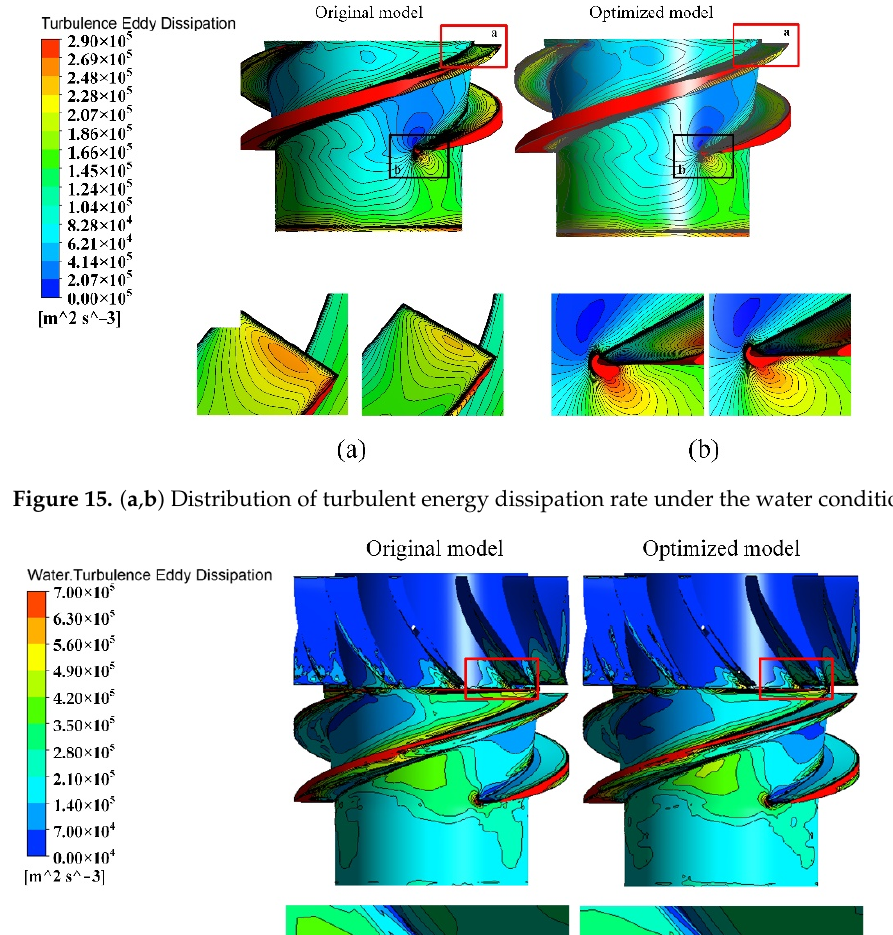
Figure 16. Distribution of turbulent energy dissipation rate under the 20%GVF condition.